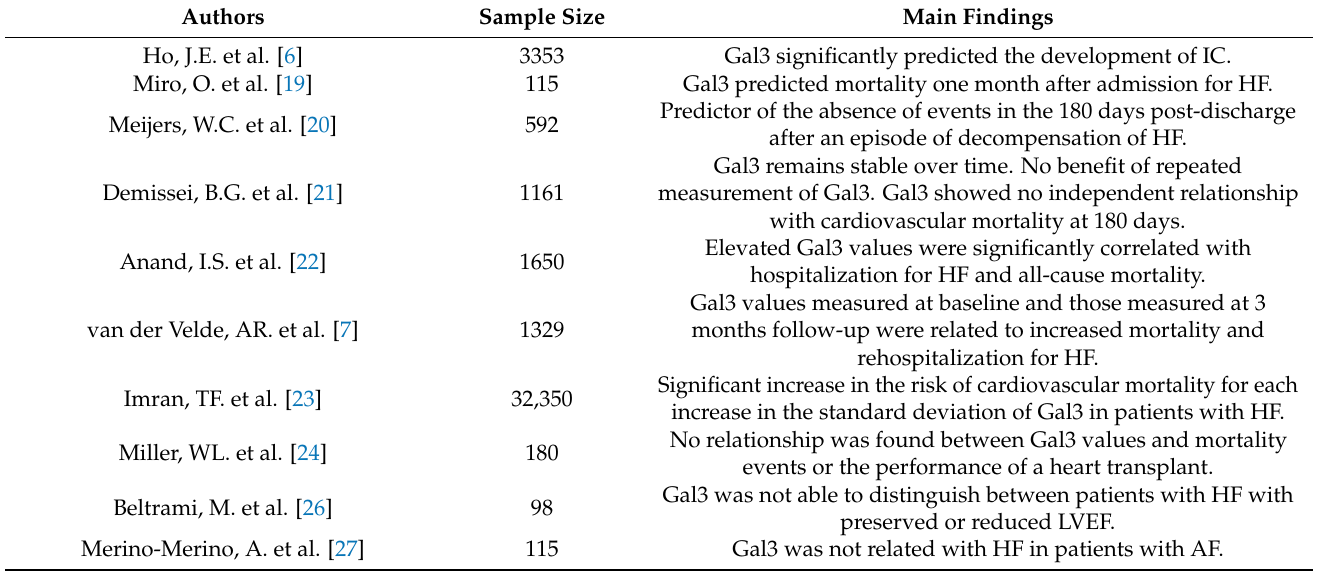
Table 1. Gal3 studies in heart